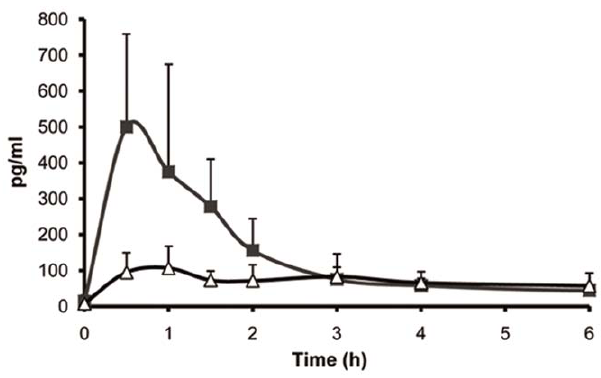
Figure 5. Plasma levels of scopolamine in pigs after short topical exposure. Test and control groups were exposed for 5 minutes to the same solution of 5% scopolamine HBr. Averaged values (means 6 s.d) of the test group ( & ) treated with gel formulation containing isolated cnidocysts and of the control group ( D ) treated with gel formulation only.